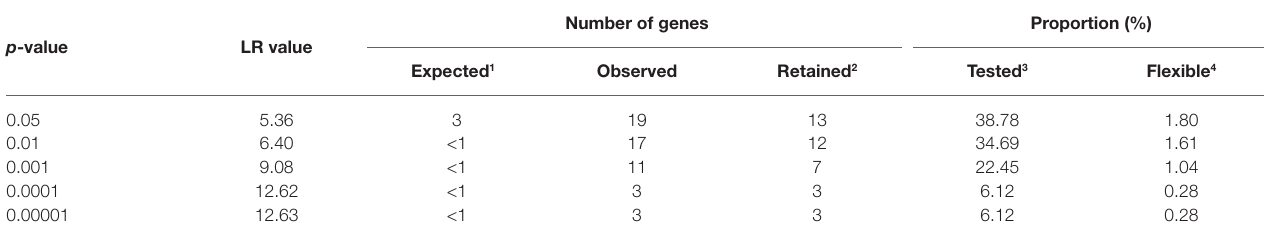
TABLE 2 | Number of genes significantly more present in Prunus spp. isolated